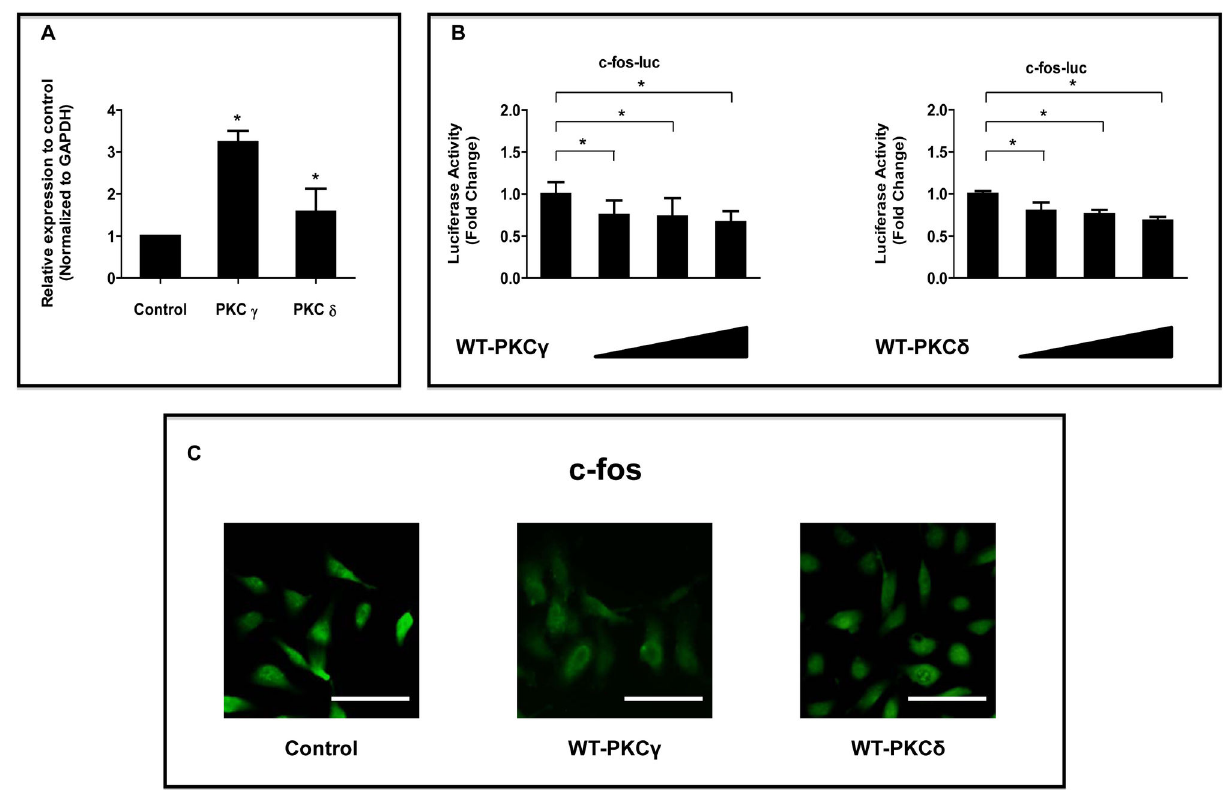
Figure 5. Effect of PMA on PKC regulation of c-fos expression in NP cells. ( A ) Real-time RT-PCR analysis of PKCγ and PKCδ mRNA levels in NP cells treated with PMA (200 nM). ( B ) NP cells were cotransfected with c-fos and increasing concentrations of the WT-PKCγ or WT-PKCδ expression plasmids (100–500 ng). * P < 0.05 indicates significant differences between groups. n.s. = not significant. ( C ) Detection of c-fos protein expression by immunofluorescence microscopy. NP cells were transfected with or without WT- PKCγ or WT-PKCδ expression plasmids, fixed, and stained with an antibody against c-fos (green). Scale bar= 50 μm (original magnification 20×). doi: